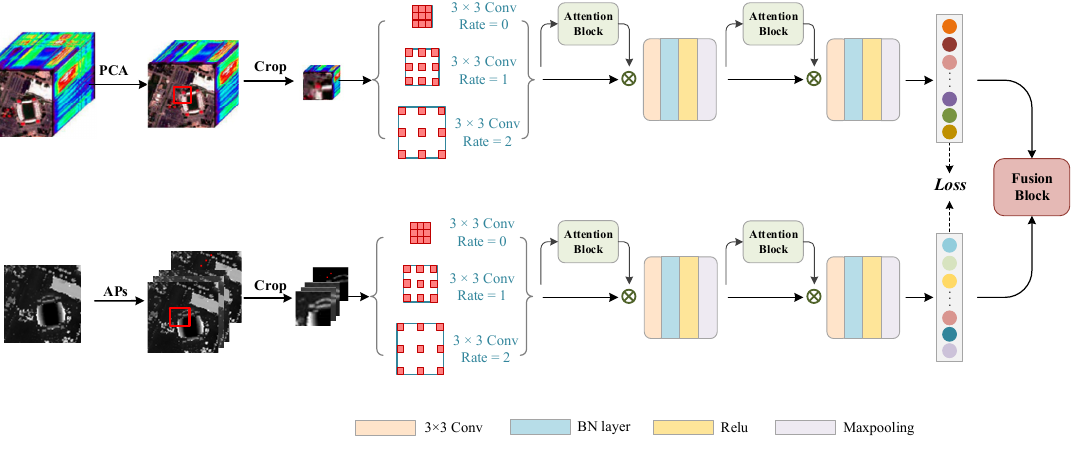
Figure 1. The architecture of the proposed MA-PSNet.